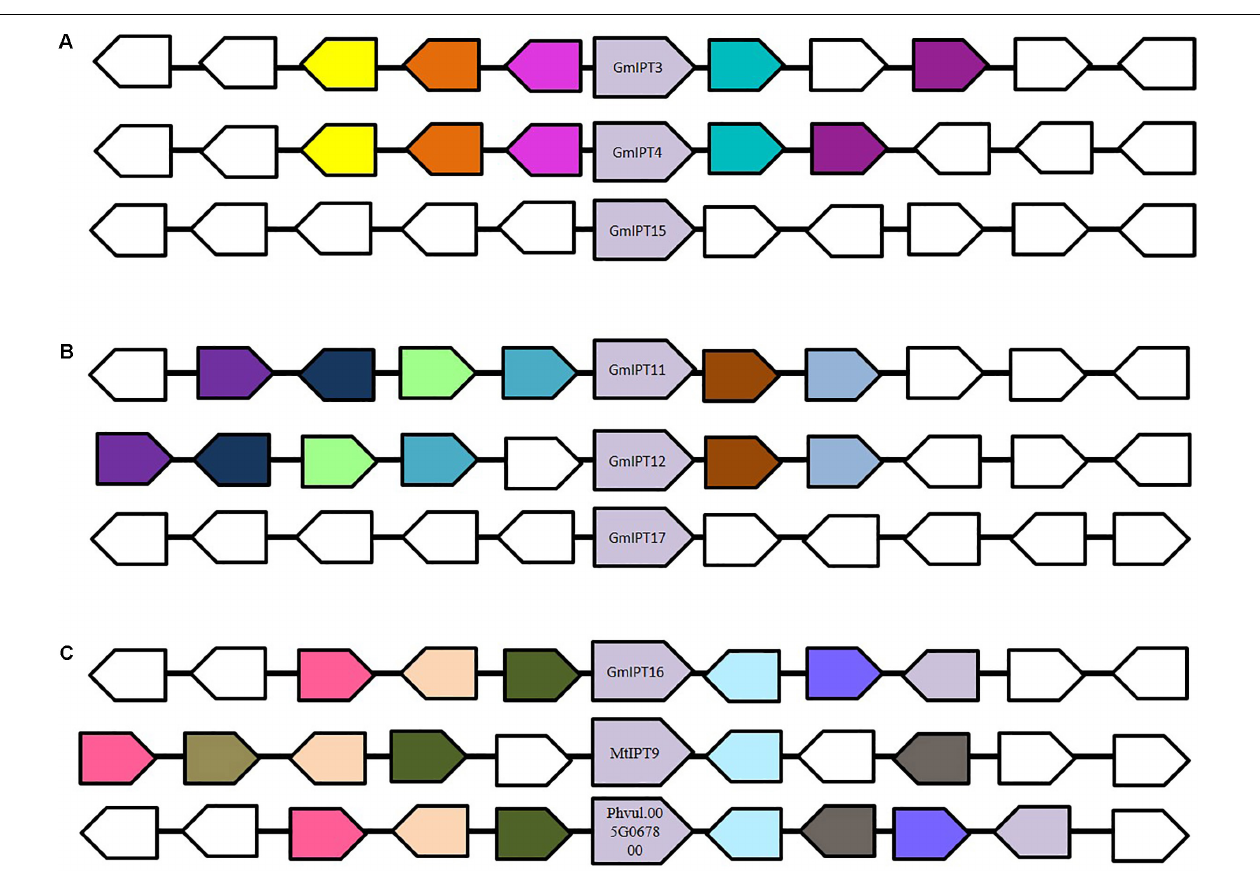
FIGURE 3 | Genomic environment of (A) GmIPT3/GmIPT4/GmIPT5 , (B) GmIPT11/GmIPT12/GmIPT17 and (C) GmIPT16 in soybean. The genes of interest are centrally positioned and highlighted in purple. Surrounding genes with an identical putative function are shown in the same colors with genes with an unrelated function left uncolored. The direction of the arrow indicates the gene direction compared to the IPT genes. (A) GmIPT3 and GmIPT4 are true homologous with a highly conserved genomic region. GmPT15 arose as a tandem duplication of GmPT3 , in which only the IPT gene was duplicated and not its environment. (B) GmIPT11 and GmIPT12 are homeologous duplicates represented by the high level of gene synteny. GmIPT17 does not share this conservation. (C) GmIPT16 does not share synteny with any of the other 16 soybean IPT genes, but its surrounding genes are highly identical to those surrounding its orthologs MtIPT9 and Phvul.005G067800 in M. truncatula and common bean ( P. vulgaris